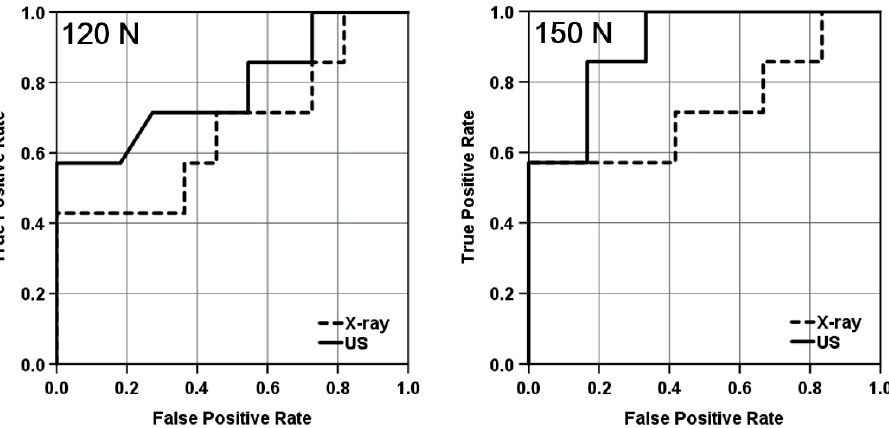
Figure 8. ROC curve indicating sensitivity and specificity of the stress X-ray test and Ultrasound stress imaging test at loads of 120 and 150 N. ROC analysis was performed in the HAS group ( n = 8). The AUC for the stress X-ray test was 0.662 ( p = 0.258) at 120 N and 0.786 ( p = 0.046) at 150 N. The AUC for the ultrasound stress test was 0.786 ( p = 0.046) at 120 N and 0.905 ( p = 0.004) at 150 N. ROC, receiver operating characteristic; US, ultrasound; HAS, history of ankle sprain; AUC, area under the